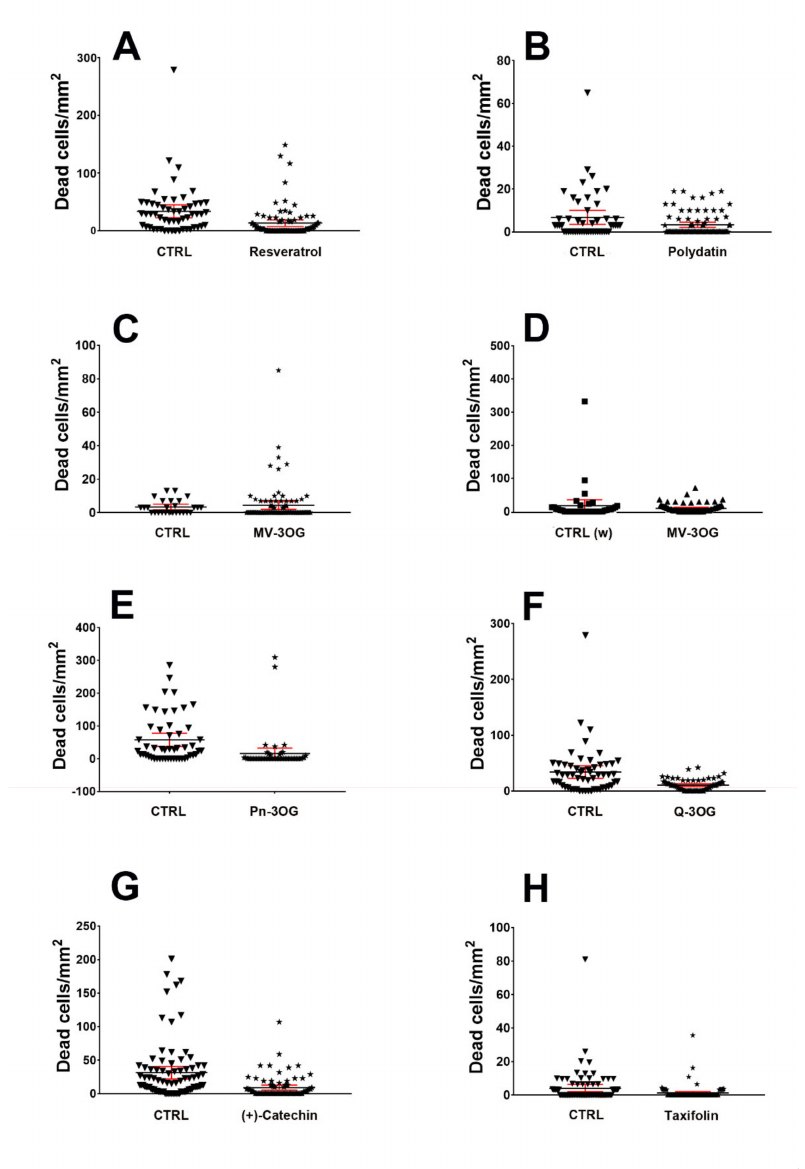
Figure 4. Descriptive exploratory statistics of the e ff ect of di ff erent polyphenols (( A ) = resveratrol; ( B ) = polydatin; ( C ) = Mv-3OG (malvidin 3-O-glucoside); ( D ) = aqueous medium-dissolved Mv-3OG; ( E ) = Pn-3OG (peonidin 3-O-glucoside); ( F ) = Q-3OG (quercetin 3-O-glucoside); ( G ) = ( + )-catechin; ( H ) = taxifolin) on cerebellar naturally occurring neuronal death (NOND). Dead cells were stained with propidium iodide and results are expressed as means of dead cells / area with 95% CI. Scatter graphs show the dispersion and variability of data. Abbreviations: CTRL = control medium containing 170 mM ethanol; CTRL (w) = control medium